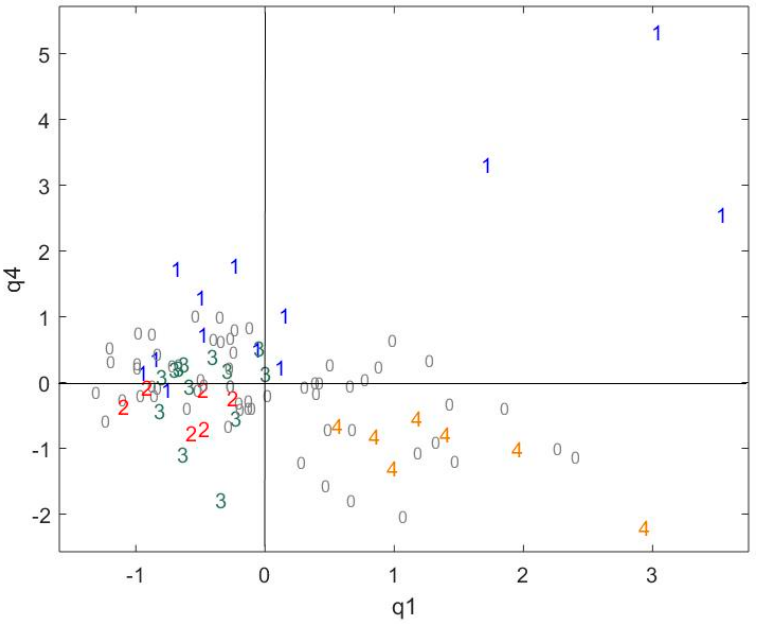
Figure 4. The CCSWA on the chocolate and cocoa data, a sample projection in the common space q1–q4. 1 = core pole 1, 2 = core pole 2, 3 = core pole 3, 4 = core pole 4 and 0 = samples not belonging to any core pole.